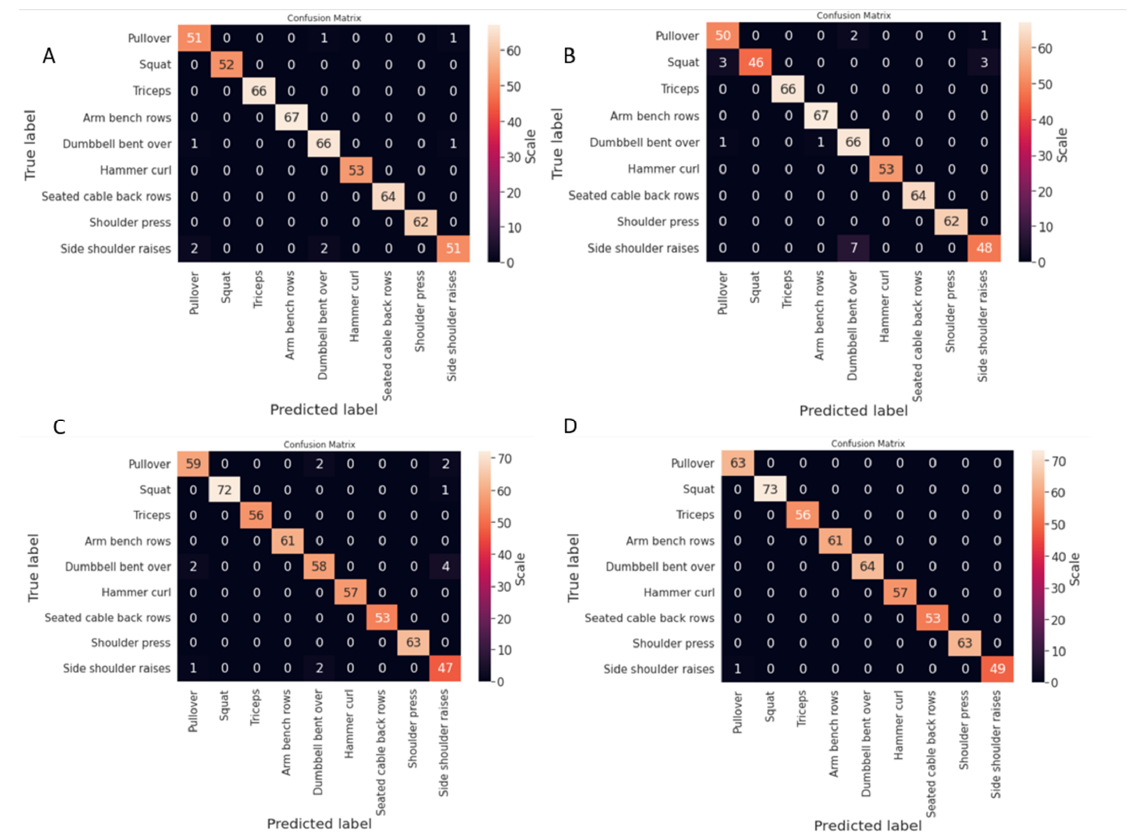
Figure 11. Evaluation metrics for all the developed models: ( A ) DT, ( B ) KNN, ( C ) SVM, and ( D ) RF.